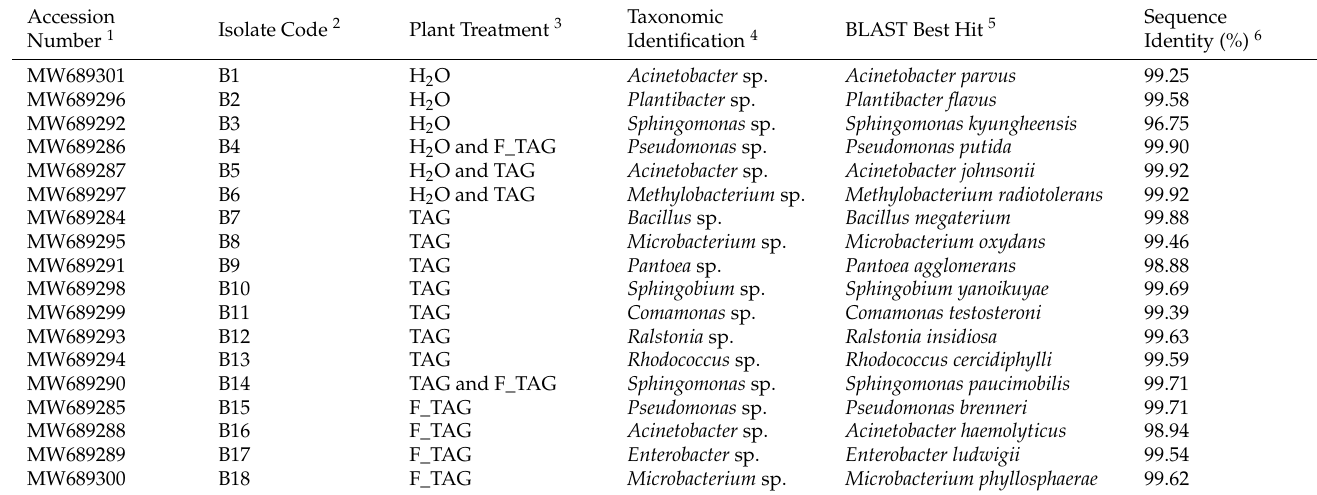
Table 1. List of potential tagatose-degrading bacteria isolated from leaf washing suspensions.